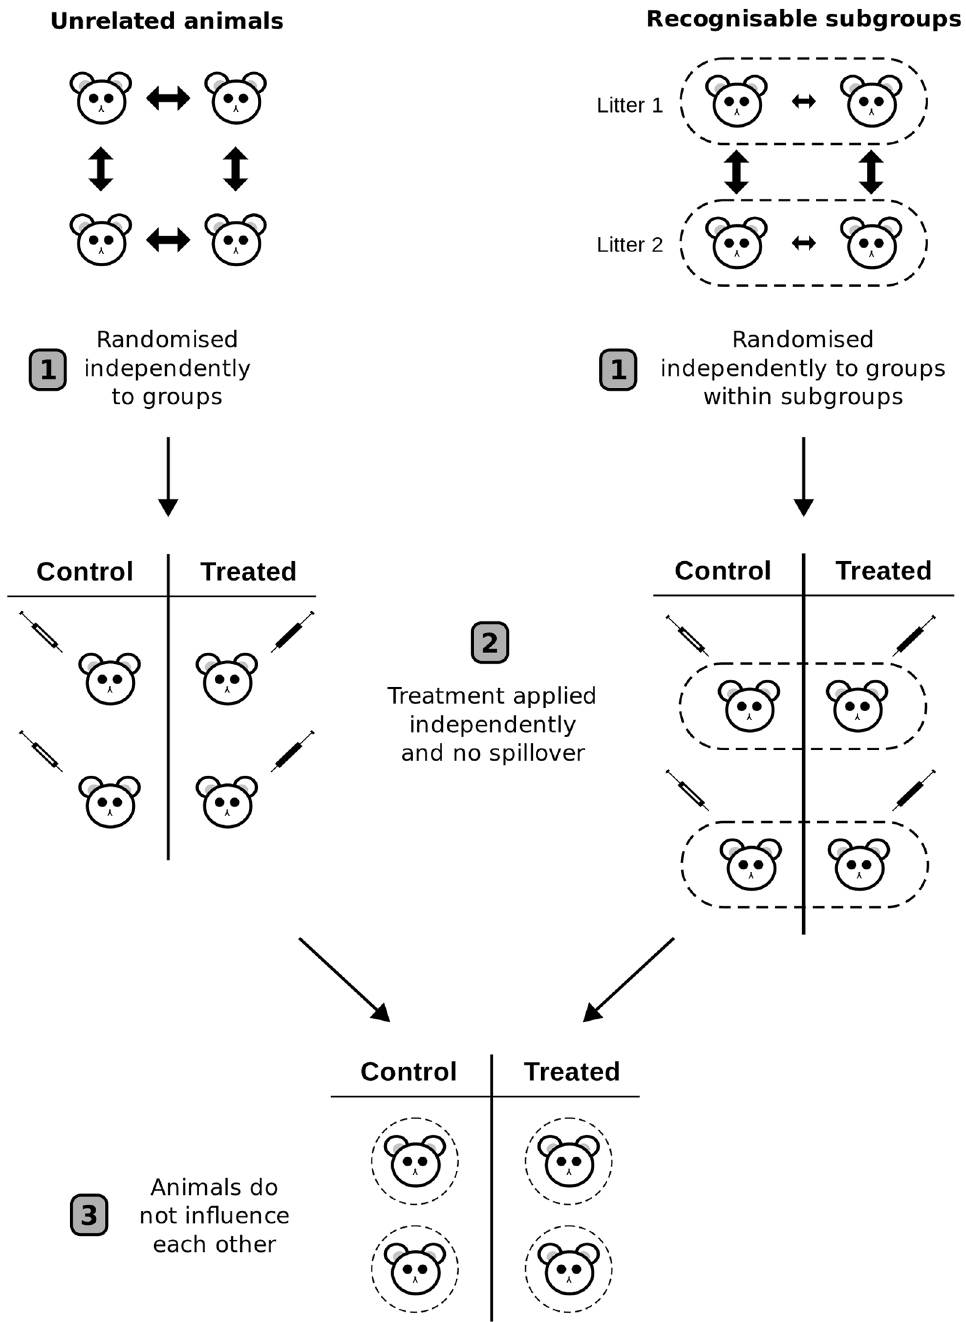
Fig 3. Three criteria for genuine replication. (1) EUs (animals) must be independently randomised to the treatment conditions. Double arrows indicate variability between EUs, and is constant when the EUs are homogeneous. This variability between the EUs is used to test for differences between treatments. If there are recognisable subgroups such as litters or sex, randomisation can be done within each subgroup. Variability will tend to be less between EUs in a subgroup (smaller arrows) than between subgroups. (2) The treatment must be independently applied to each EU and must not affect or spillover to adjacent EUs. The syringes represent the application of an intervention to the EUs (white = control, black = treated). (3) The EUs must not influence each other (dashed circles represent animals isolated from influencing each other), especially on the outcomes of interest. Adapted from Lazic [21]. EU, experimental unit.